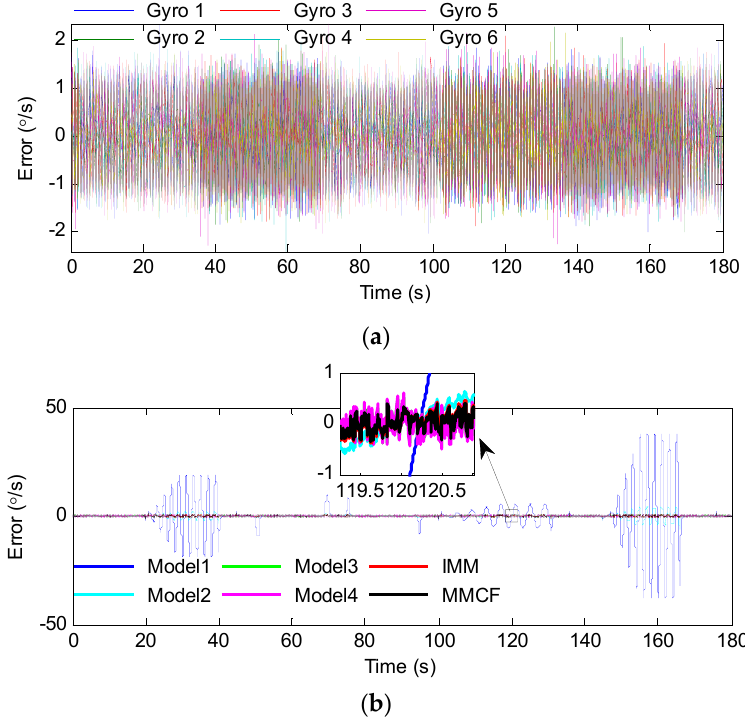
Figure 10. Errors of the overall outputs: ( a ) The output errors of individual gyroscopes; ( b ) the angular rate errors of the gyro array estimated by using different methods.